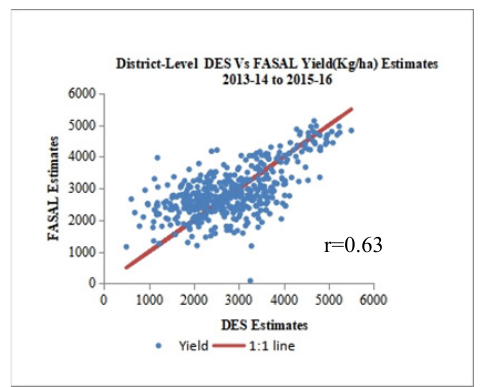
Figure 10. District-wise Area ('000 ha), DES and FASAL Estimates (2013-14 to 2015-16)